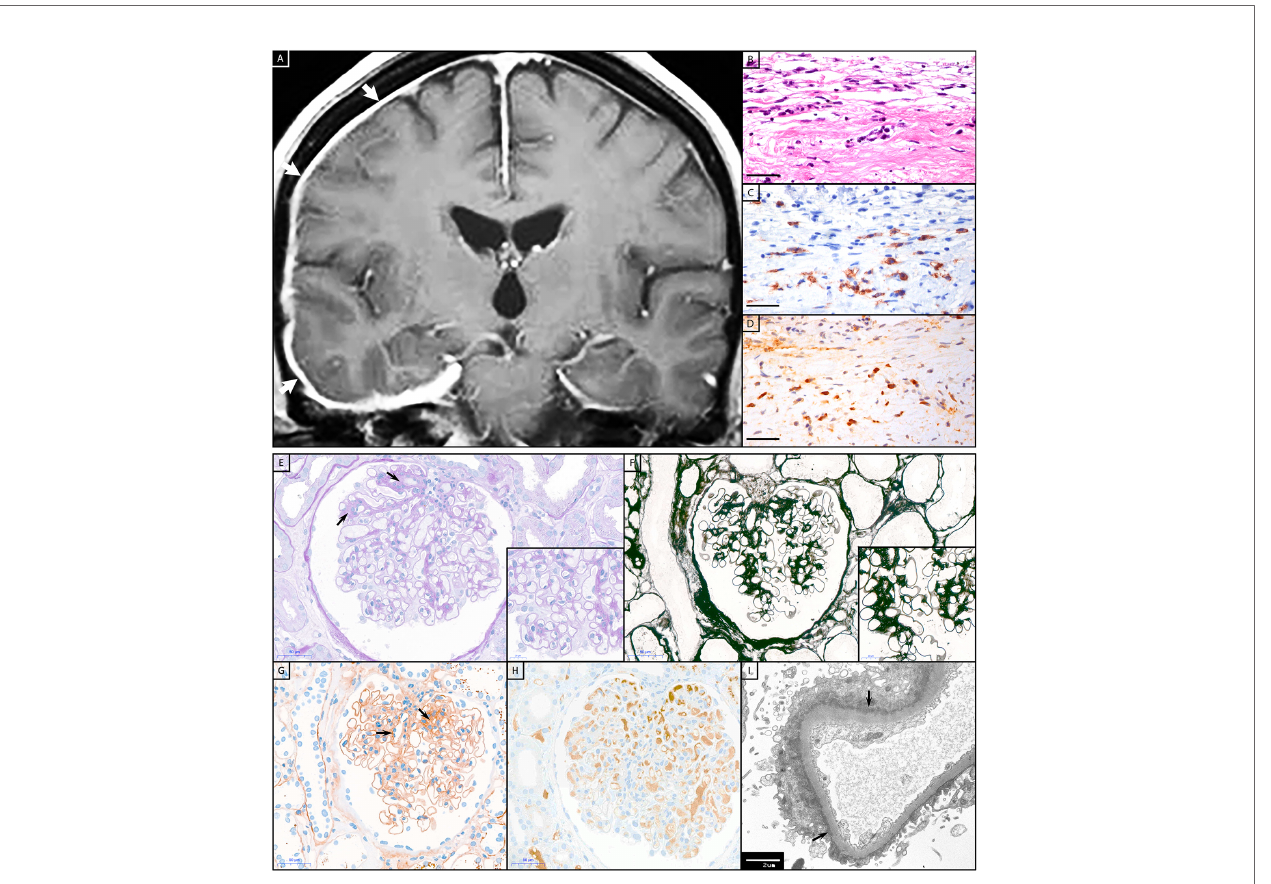
FIGURE 5 | Histopathology of IgG4-RLD and IgG4-AID patients. Patient with IgG4-RLD: (A) MRI shows a right-sided thickening and increased contrast agent uptake of the pachymeninges (white arrows). A biopsy from the meninges reveals fragments of dura with (B) prominent fi brosis and in fi ltration with (C) numerous CD138 + and (D) IgG4 + plasma cells, compatible with IgG4-related pachymeningitis. Patient with IgG4-AID: A kidney biopsy from a patient with CNTN1/Caspr1- complex autoantibodies and acute kidney failure, nephrotic syndrome, hypoalbuminemia and microhematuria. (E) Glomerulus with mild segmental fi brous mesangial expansion (arrows), somewhat thickened capillary basal membranes, without hypercellularity (PAS stain). (F) Silver stain with smooth capillary loop basal membranes. (G) Immunohistochemistry for IgG with global fi nely granular peripheral and segmental mesangial positive deposits (arrows). (H) Negative immunohistochemistry for IgG4. (I) Electron microscopy with numerous small sub-epithelial electron-dense deposits with fl attening of podocytic foot processes (arrows). Scale bar (B – D) , (E – H) = 50 µm; scale bar inset in (E, F) = 20 µm; scale bar (I) = 2